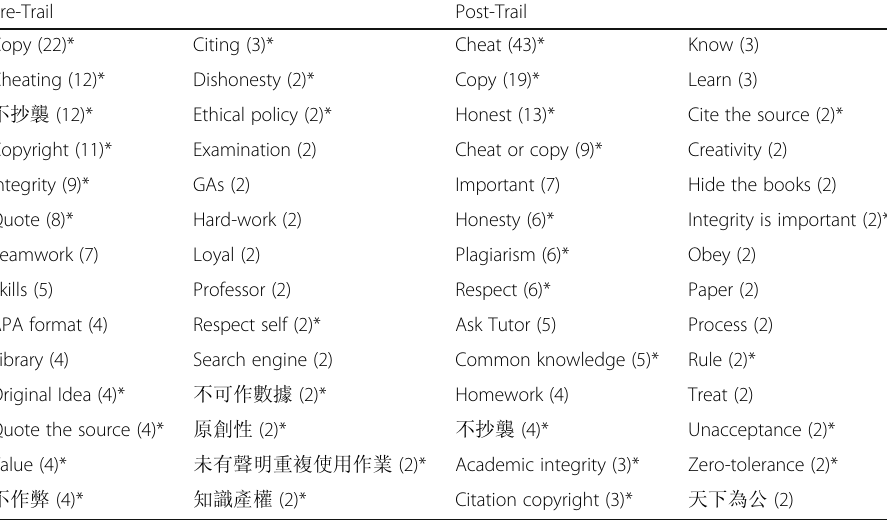
Table 5 First year students ’ pre-/post-trail terms/phrases clusters from Carrot